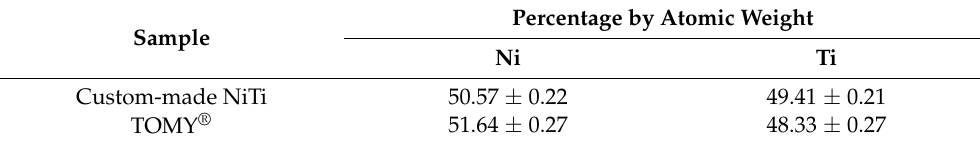
Percentage by Atomic Weight Ni Ti